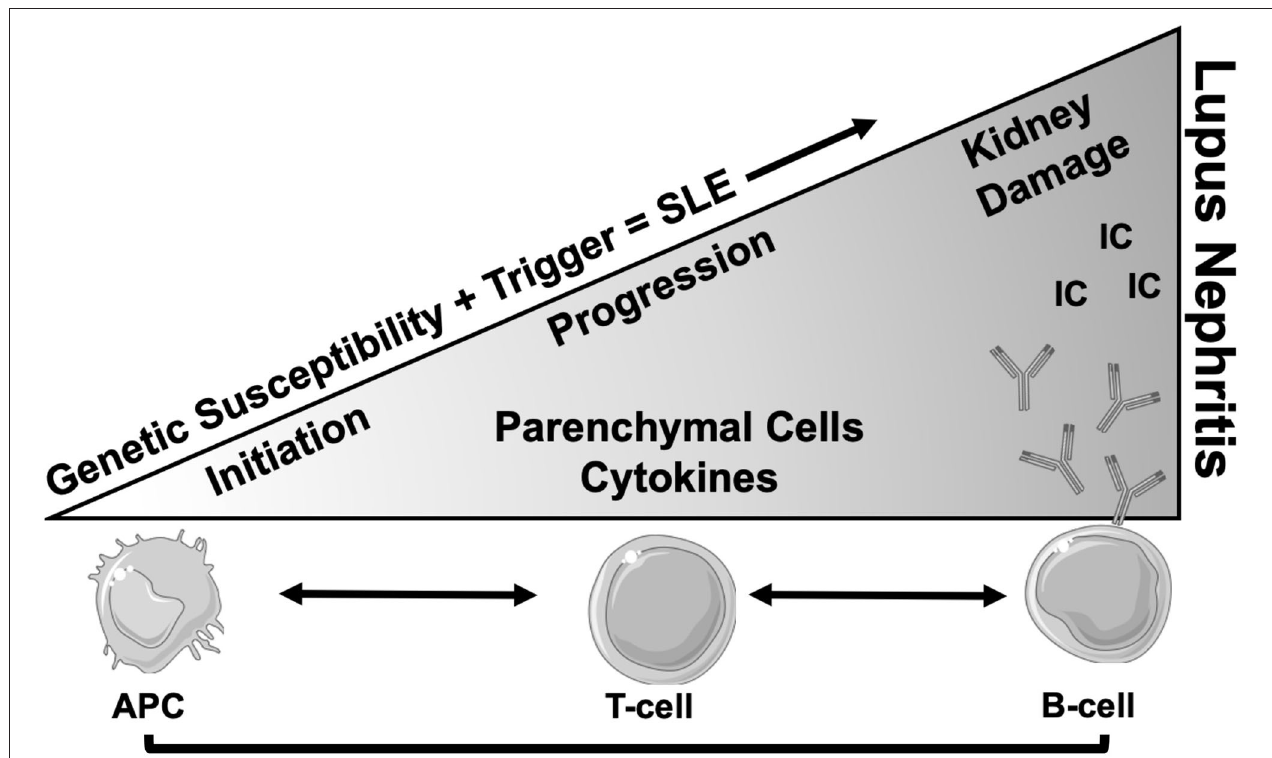
FIGURE 1 | Schema of progression of SLE to end organ renal disease (LN). After the onset of SLE in a genetically susceptible individual, there is involvement of multiple cells types involving both innate and adaptive immune systems. The antigen presenting cells (APC) present self-antigens from various sources to T lymphocytes, which results in generation of auto reactive T cells with low activation threshold. These CD4T lymphocytes in turn instruct B cells to produce autoantibodies (Y) of different specificities. Not much is known about the cause and initiation of renal disease, but in-situ generated or circulating immune complex (IC) deposits in the glomeruli are the most plausible culprits. This leads to progressive glomerular pathology and secretion of chemokines, cytokines and matrix proteins, resulting in immune cell infiltration and tissue damage. Loss of glomerular permeability also leads to tubulointerstitial injury which is perpetuated by intrinsic tubular cell inflammatory phenotype and infiltrating immune cells which eventually leads to renal